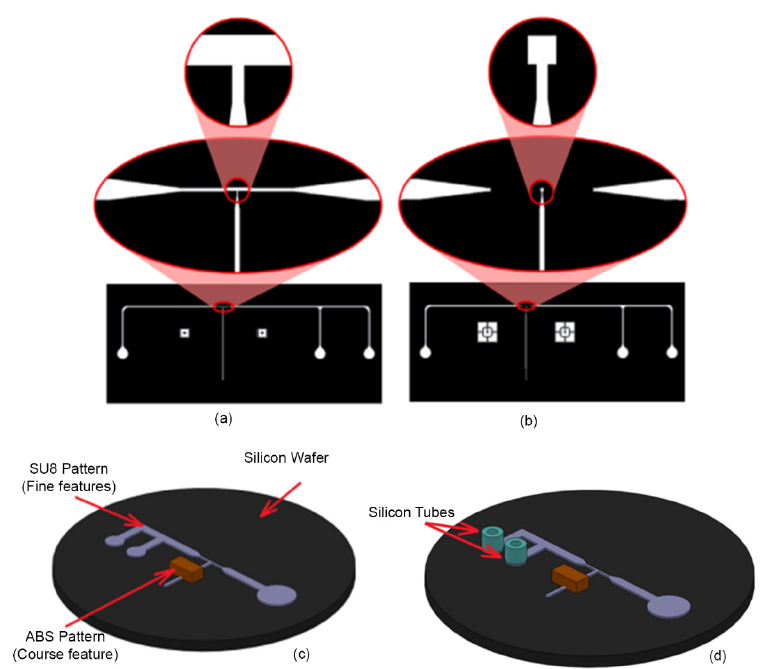
Figure 6. The microchannel pattern for ( a ) the first and ( b ) the second layer of the microchannels. ( c ) The master mold composed of two types of molds (course and fine features). The SU8 pattern on Silicon wafer defined the fine features with resolution of 10 µm and the ABS pattern used to create the course features with minimum resolution of 100 µm. ( d ) The master mold after putting silicon tubes (ID 1.5 mm of and OD of 4.8 mm and 10 mm length) on the SU8 patterns in order to have access to the inlet and washing channel after PDMS casting.